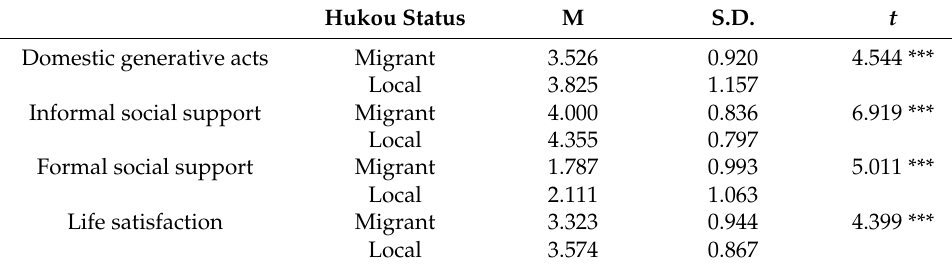
Table 3. Differences of main variables by Hukou status.